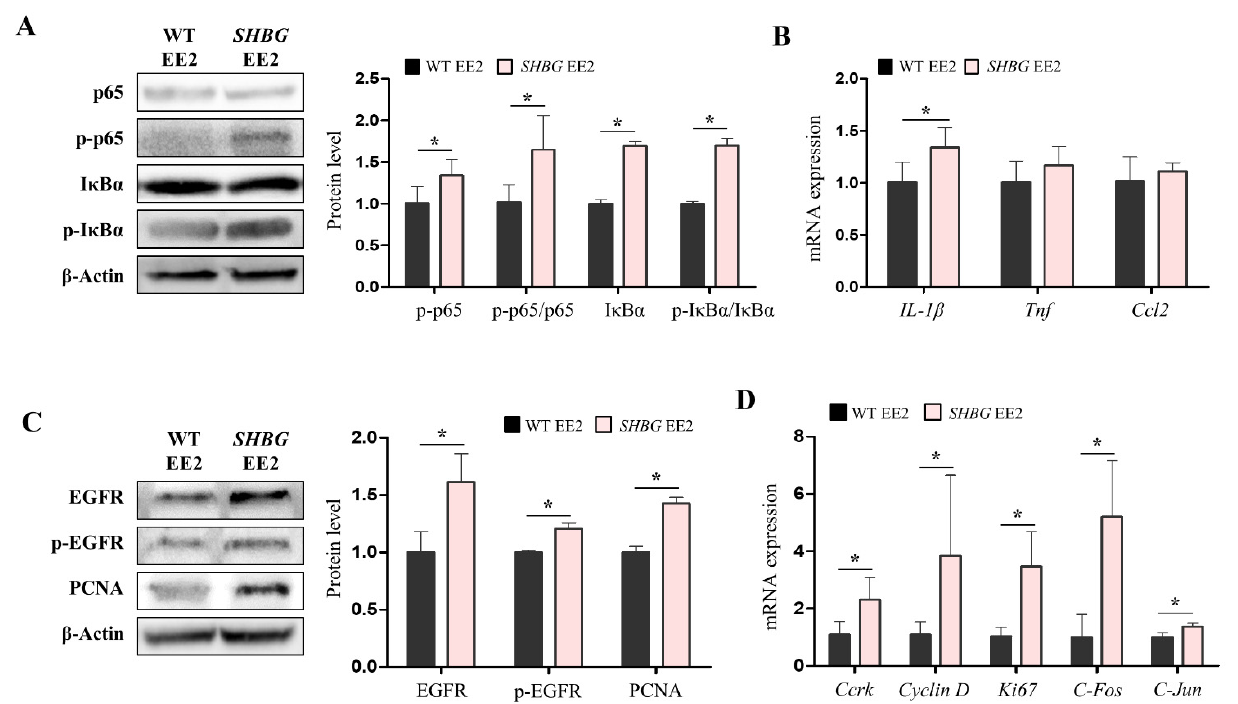
Figure 4. Pro-inflammatory response and compensatory proliferation were promoted in SHBG mice fed with EE2. ( A ) Western blot analysis and quantification of intact and phosphorylated p65 NF- κ B and I κ B α in livers of WT EE2 and SHBG EE2 mice. β -Actin was used for an internal control. ( B ) mRNA expression of IL-1 β , Tnf, Ccl2 in livers of WT EE2 and SHBG EE2 mice. Rplp0 was used for an internal control. ( C ) Western blot analysis and quantification of intact and phosphorylated EGFR, and PCNA in livers of WT EE2 and SHBG EE2 mice. β -Actin was used for an internal control. ( D ) mRNA expression of Ccrk , Cyclin D , Ki67 , C-Fos , and C-Jun in livers of WT EE2 and SHBG EE2 mice. Rplp0 was used for an internal control. Numbers of mice used for experiments were: WT EE2 (8), SHBG EE2 (8). Student’s t -Test was used for analysis. Values represent means ± SD. * p < 0.05. Data were quantified from replicated values in which independent experiments were performed in triplicate at least.